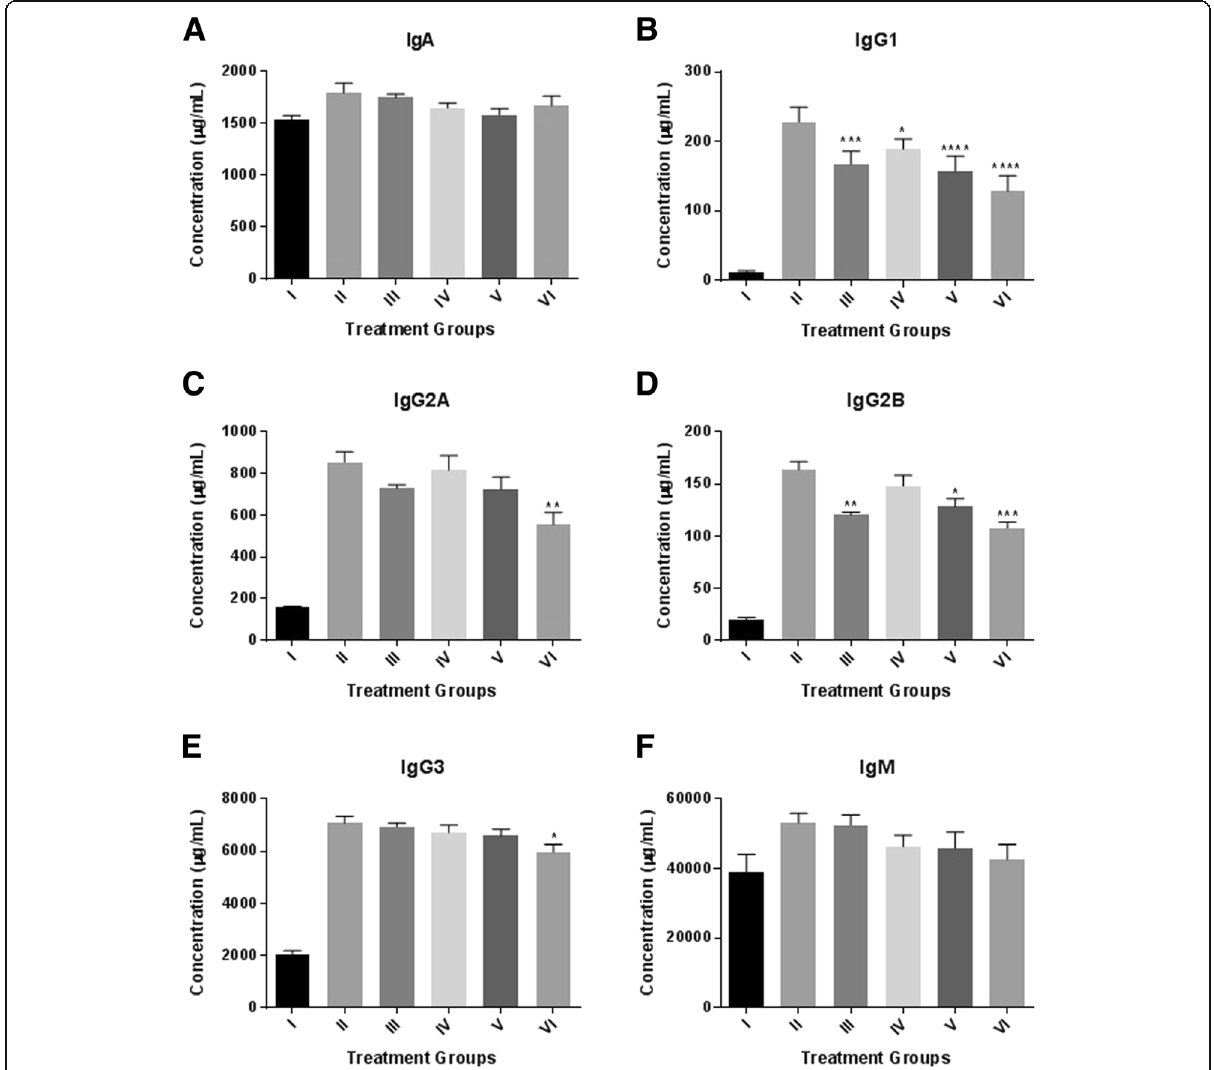
Fig. 5 Immunoglobulin levels of control and D. morbifera Léveille-treated mice. a IgA, b IgG1, c IgG2A, d IgG2B, e IgG3 and f IgM. All the tested immunoglobulins showed a dose-dependent reduction in treatment with D. moribifera Léveille, except for IgA. Group VI showed a significant reduction IgG2A levels. IgG2B was significantly reduced in groups III, V and VI. IgG3 showed significant suppression in group VI mice. No significant difference was observed between the IgM treatment groups. (* = P value < 0.05; ** = P value < 0.01; *** = P value< 0.001; **** = P value < 0.0001; all the comparisons were made using the untreated control